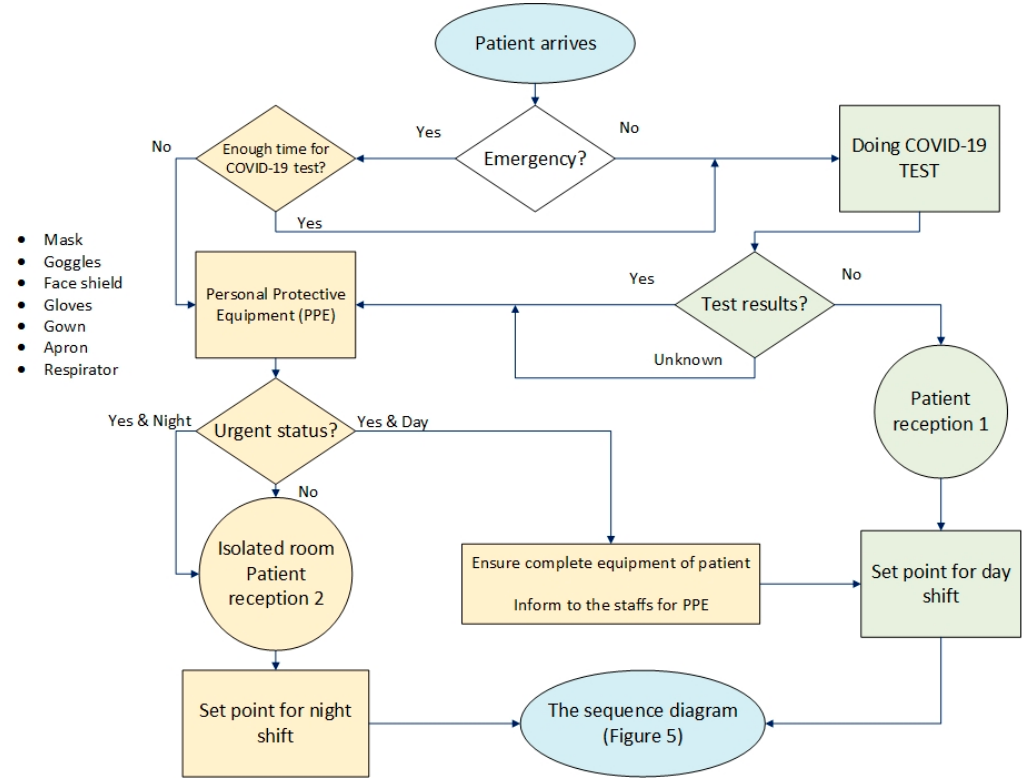
Figure 12. The proposed framework for heart clinics during COVID-19 pandemic.